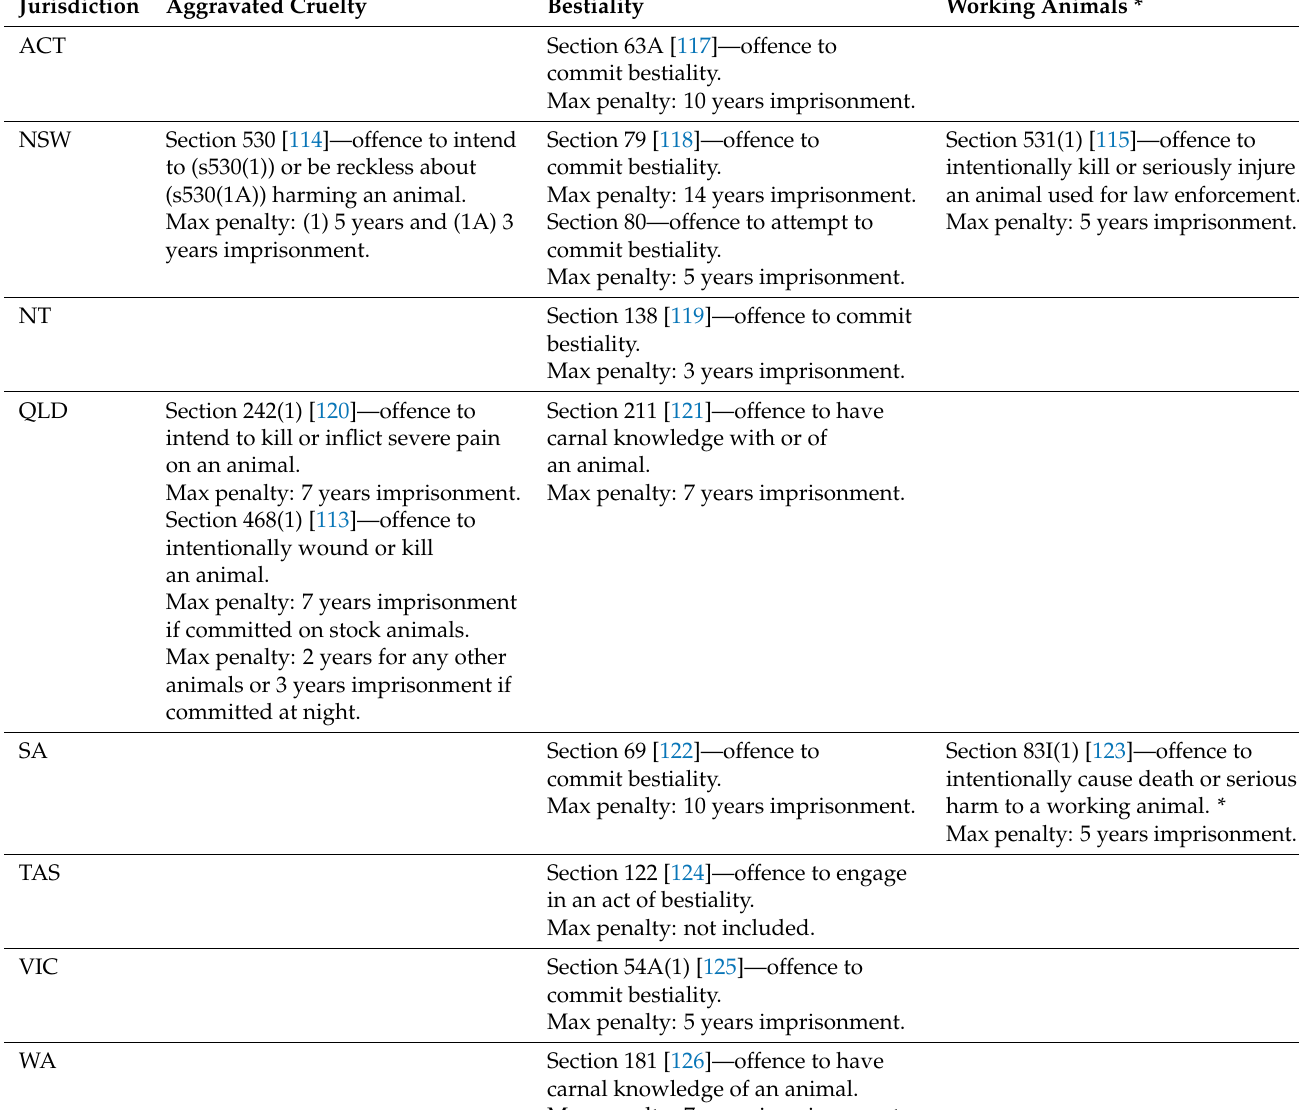
Table 10. Each offence relating to animal protection included in the Australian state and territories’ crimes acts. Offences are broken down into acts of aggravated animal cruelty, bestiality and provisions to protect working animals. Offences have been paraphrased. Penalties are applicable to natural persons; separate penalties apply for body